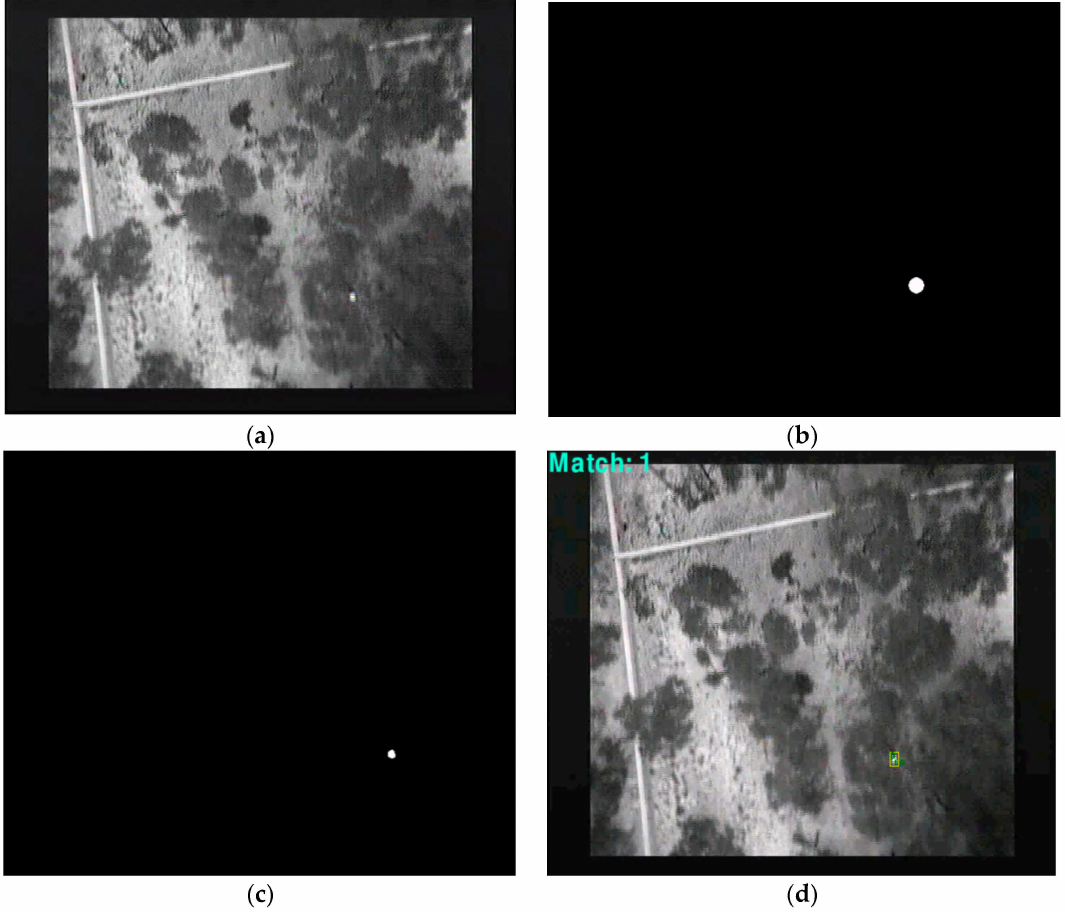
Figure 14. ( a ) Image of Canopy with Detection at 60 m ( b ) Mask created ( c ) Background removal, ( d ) Tracking and displaying.